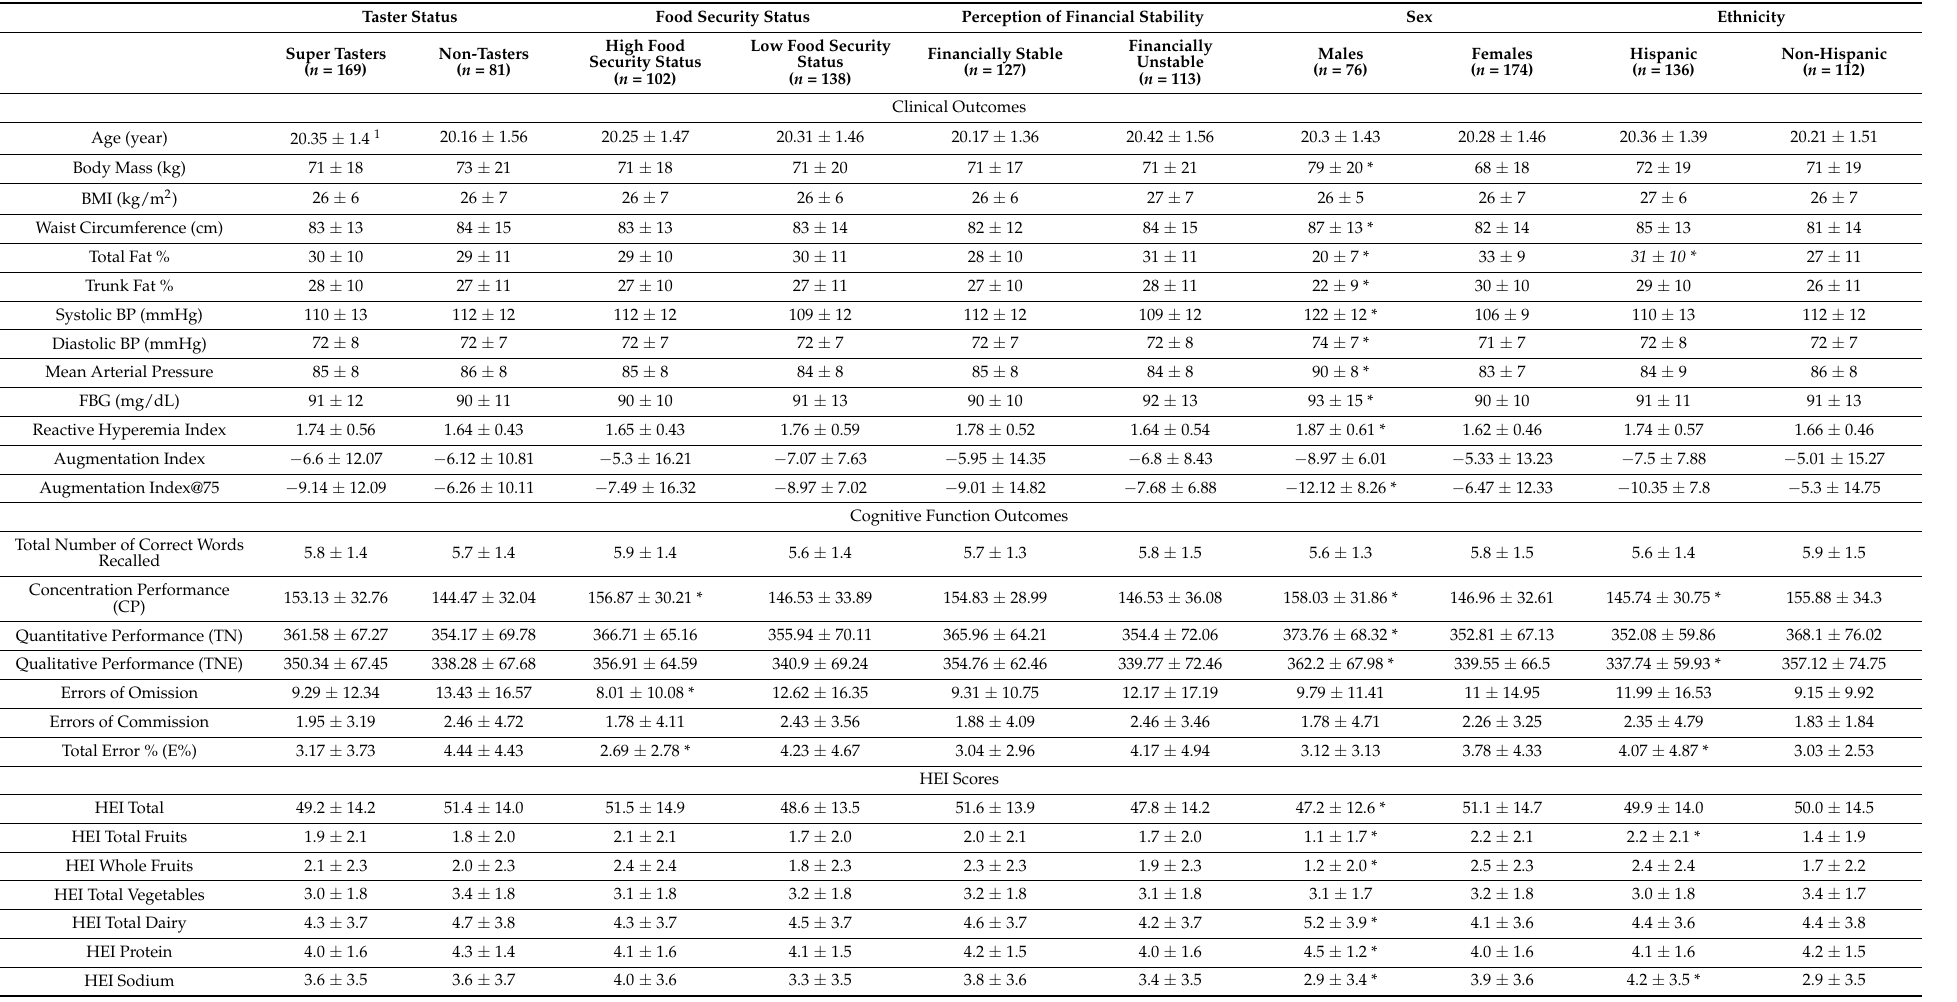
Table 2. Clinical, cognitive function, and HEI characteristics by taster, food security status, perception of financial stability, sex, and